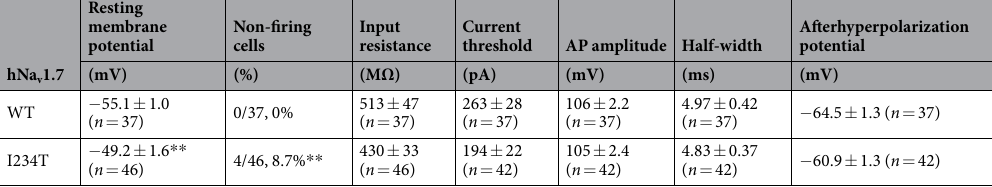
(Table 1), with RMPs of − 15.2 mV, − 16.0 mV, − 28.8 mV and − 38.0 mV (magenta, Fig. 1A), remained silent